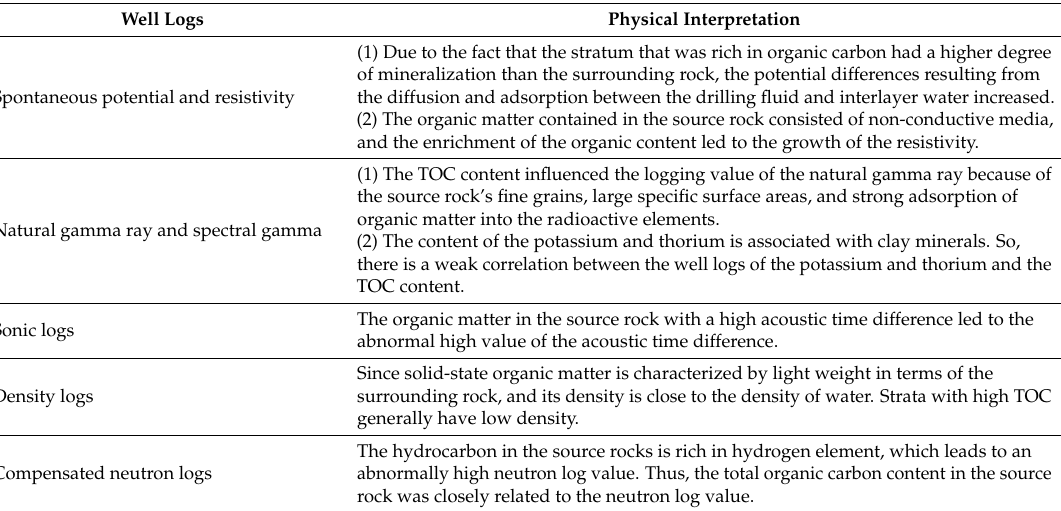
Table 3. The logical relationship between Well logs and